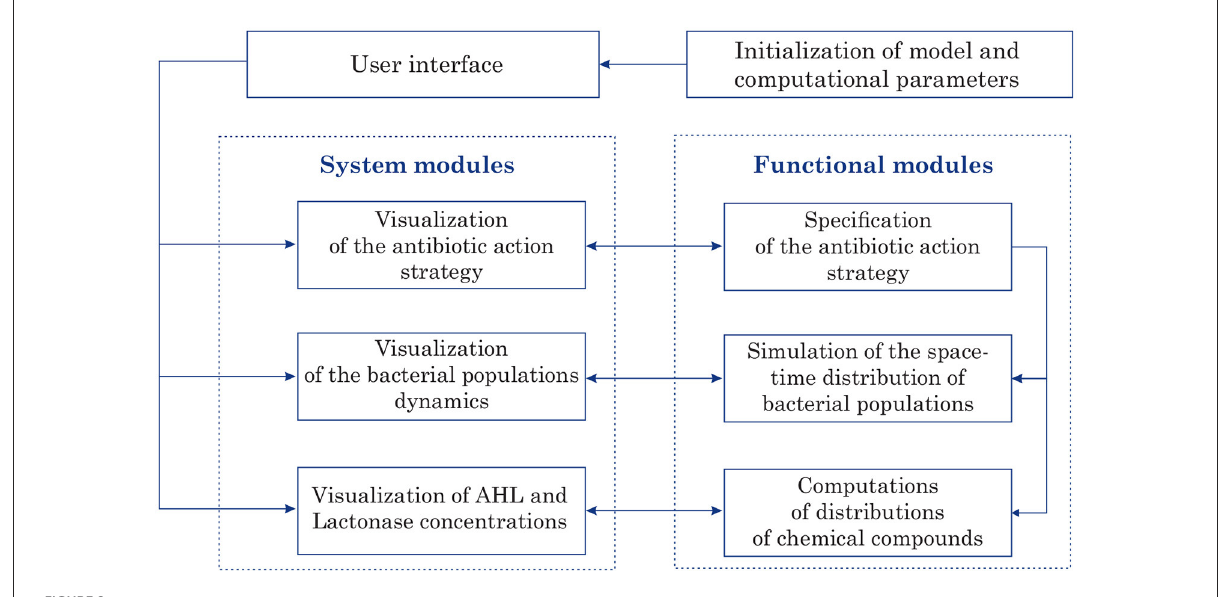
FIGURE2 The program application architecture diagram.